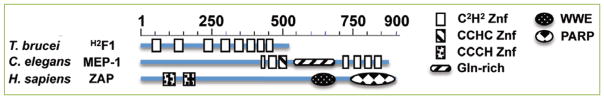
Domain organization at scale of known zinc finger cofactors of DEAH-RHA proteinsDomain annotations in NCBI’s CD-search predictions. Identification of the zinc fingers in H2F1 is described in Fig. 6. The domains in MEP1 (Q21502 - MEP1_CAEEL) are not detected in a CD-search analysis but are annotated in UniProtKB. Predicted Znf domains in ZAP isoform 1 (Q7Z2W4 (ZCCHV_HUMAN) are not detected in a CD-search analysis but are annotated in UniProtKB and were identified in a crystal structure of the N-terminal fragment in a homolog protein [16]. Detected conserved domains are WWE (smart00678) and PARP (pfam00644).